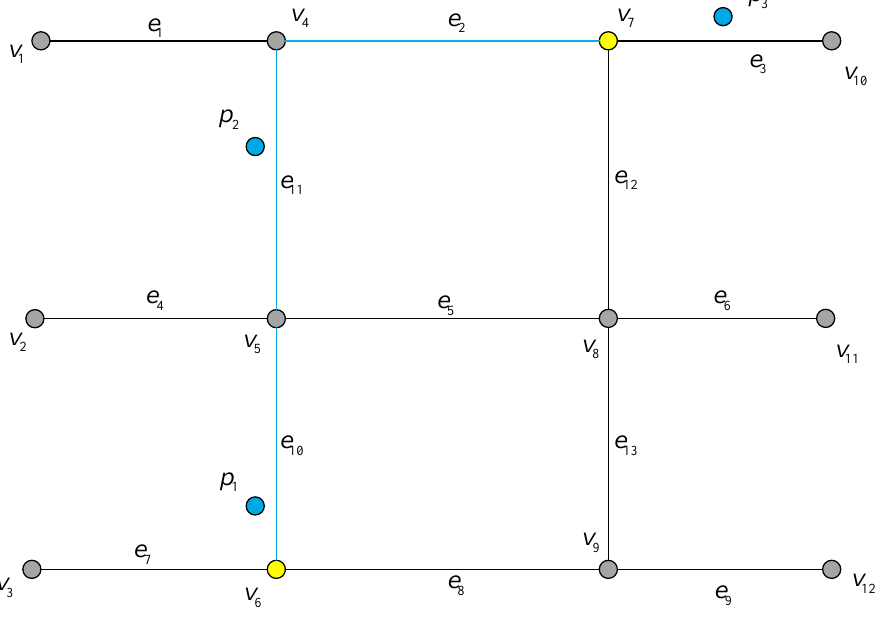
10 of 23 Figure 6. Creating the trajectory buffer. Step 2 (Find matching paths): Each segmented sub-trajectory 𝜏 𝑖𝑘 = {𝑝 𝑖𝑎 , 𝑝 𝑖𝑎+1 , … , 𝑝 𝑖𝑏 } corresponds to a trajectory buffer. Due to the large distance between two location points in the low-frequency trajectory, two continuous points are usually matched to two uncon- nected road segments in the road network, which may be far apart. Thus, we need to find possible paths between them. Let us take 𝜏 𝑖𝑘 as an example, for 𝑝 𝑖𝑎 , there are m possible